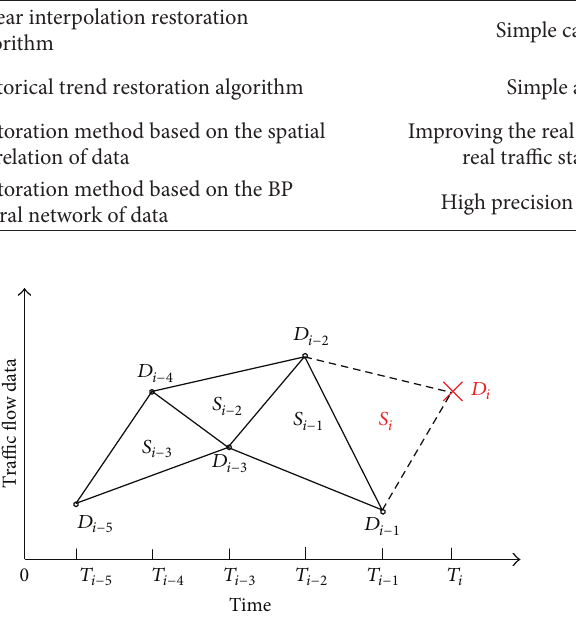
Figure 4: Sketch map of triangle area geometry by traffic flow